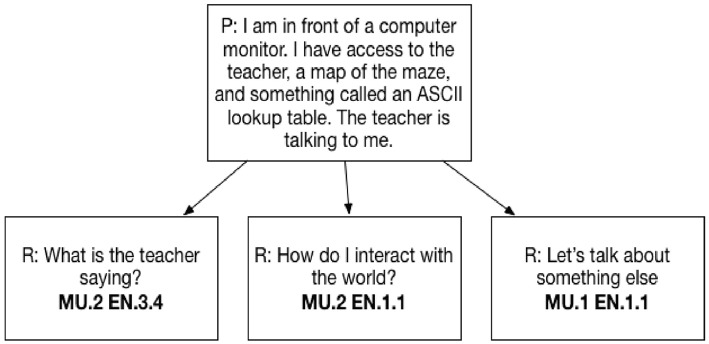
CPS response coding.